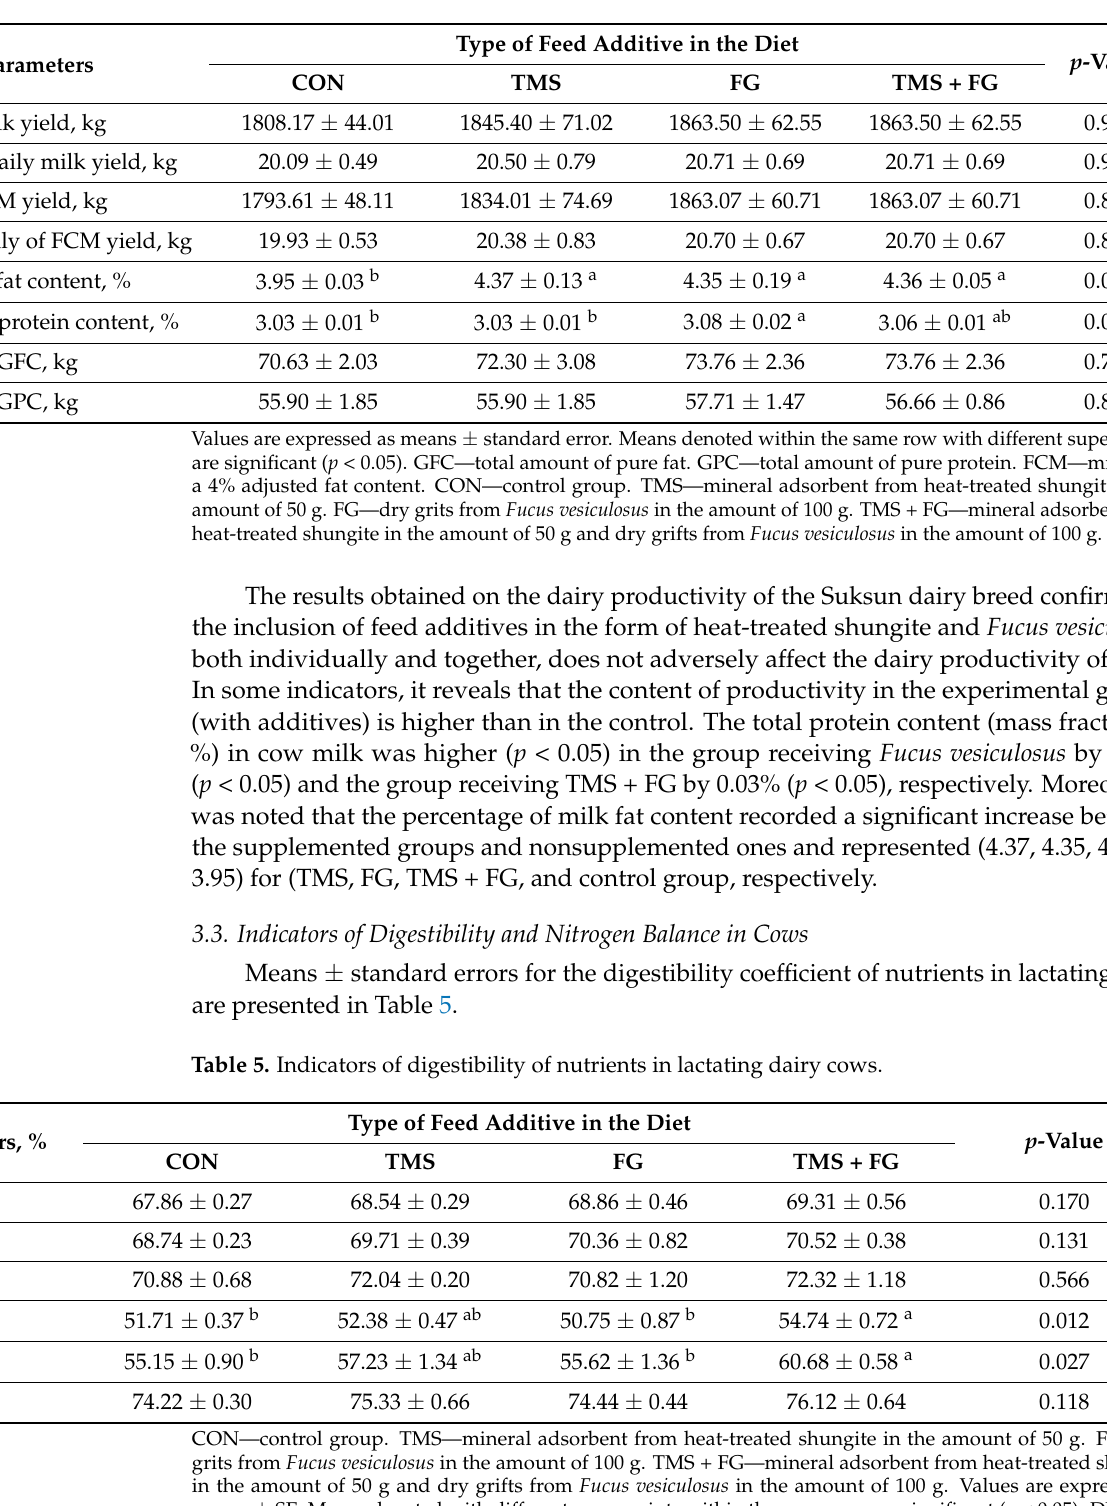
Table 4. Milk productivity and quality indicators of the Suksun cows breed (90 DIM).